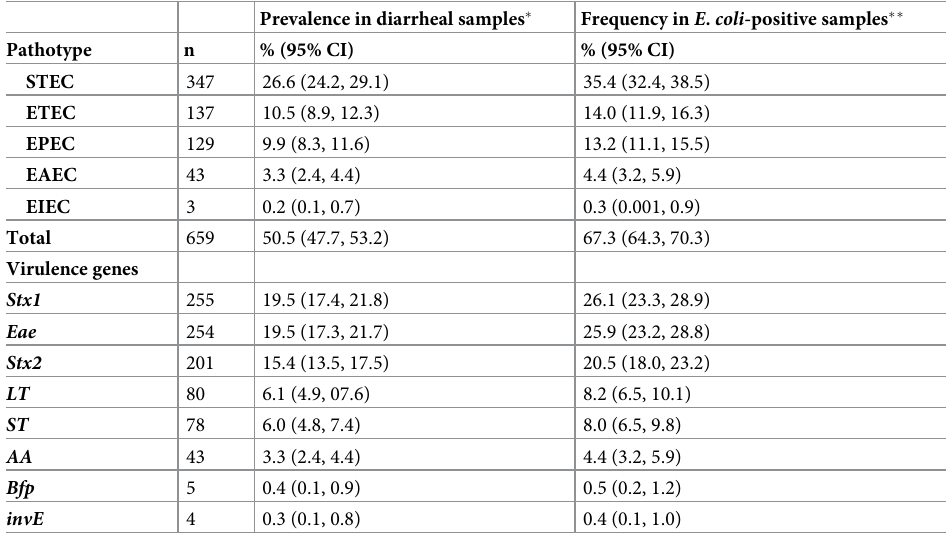
pathotype (Table 2). Table 2. Prevalence of five E . coli pathotypes and their virulence genes in